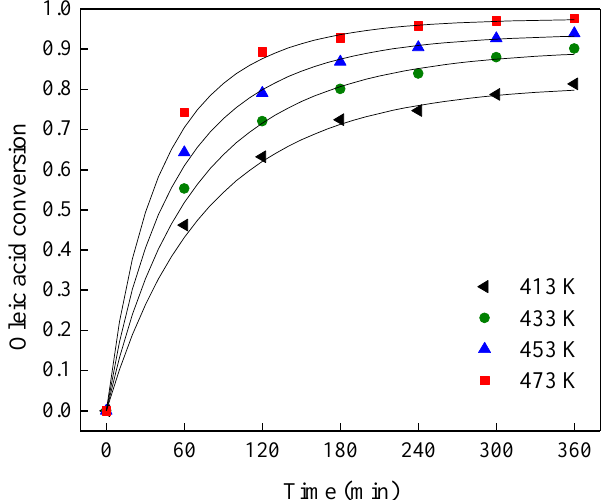
Figure 3. Influence of temperature on esterification reaction. Reactions occurred at a molar ratio of ethanol to oleic acid of 2:1 and microwave power of 150 W.